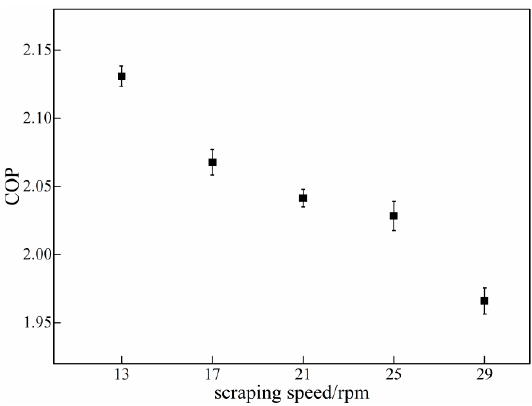
Figure 14. Effects of scraping speed on COP.